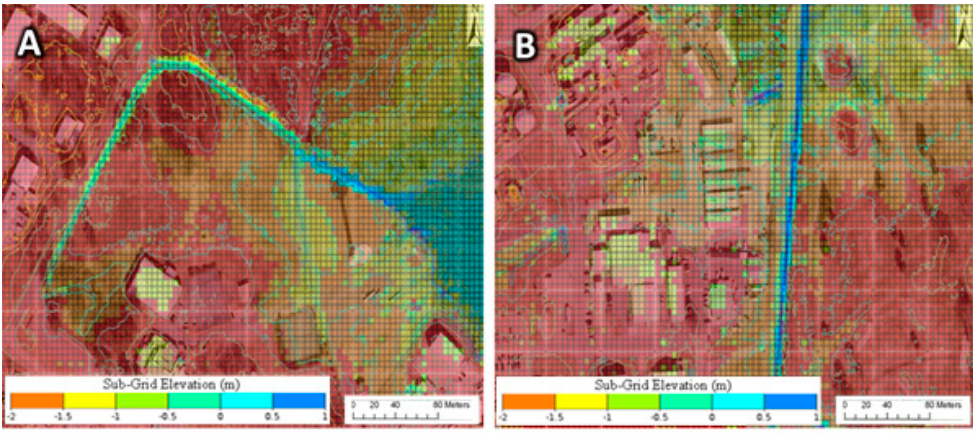
Figure 12. Ditches extracted and represented at the sub-grid DEM pixel level for effective representation of drainage ditches leading to ( A ) the west edge of Tabbs Creek and ( B ) the south edge of the creek draining the fairways of Eaglewood Golf Course, both identified for hydro-correction in Hampton, VA, USA.